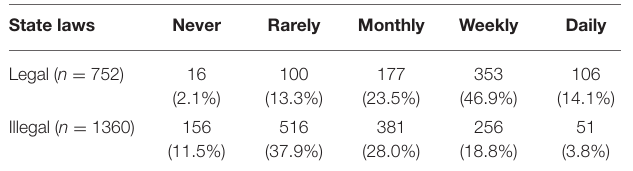
TABLE 2 | Reported frequency of clients seeking information about CBD for pets, based on legal status of recreational marijuana in state of